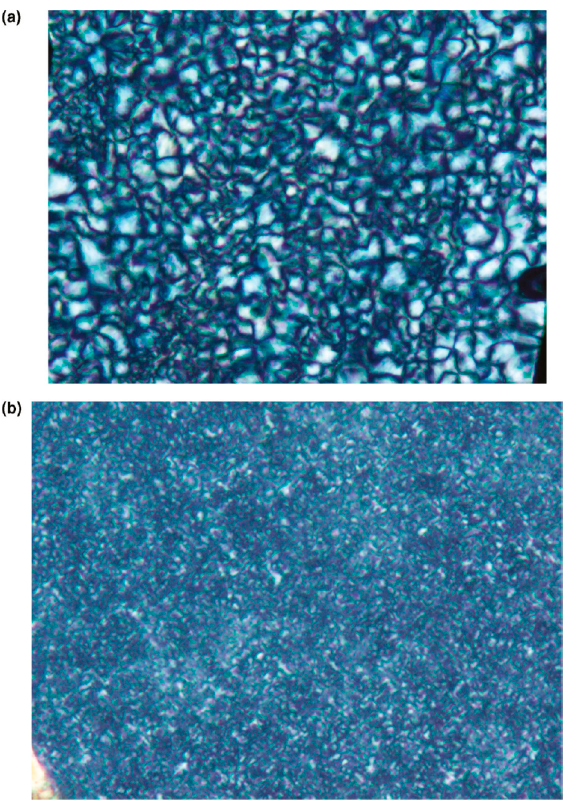
Figure 6. ( a ) Polarized micrograph of nylon-6 (MW = 600,000) film crystallized from the melt. ( b ) Polarized micrograph of nylon-6 (MW = 600,000) film with 2 wt % 3:1 (n-s) nylon-6 (MW = 600,000) α –CD IC crystallized from the melt, reproduced from [8] with permission, copyright American Chemical Society, 2009.